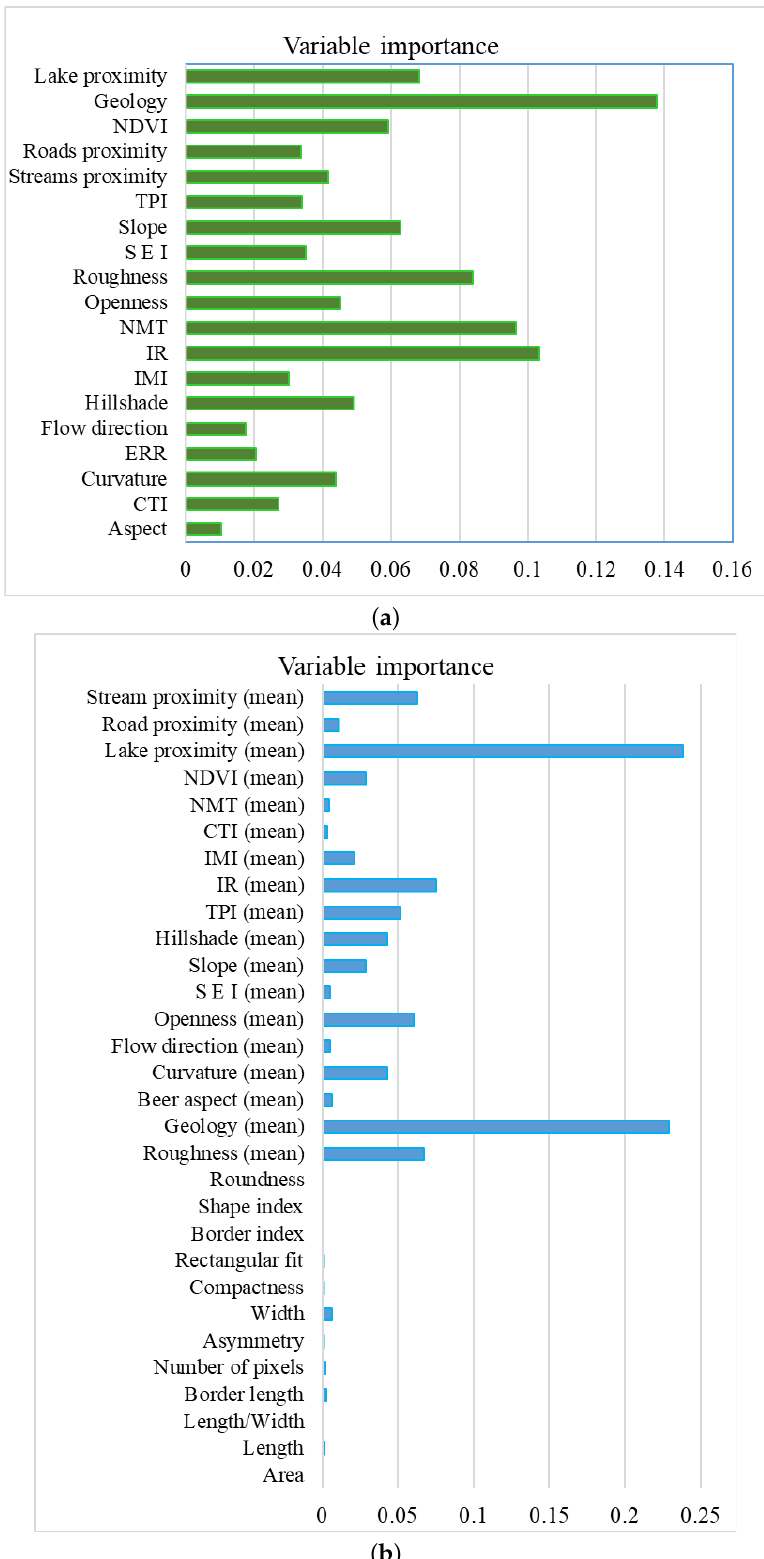
Figure 8. Variable importance assessed based on the random forest algorithm for pixel-based ( a ) and object-based approaches ( b